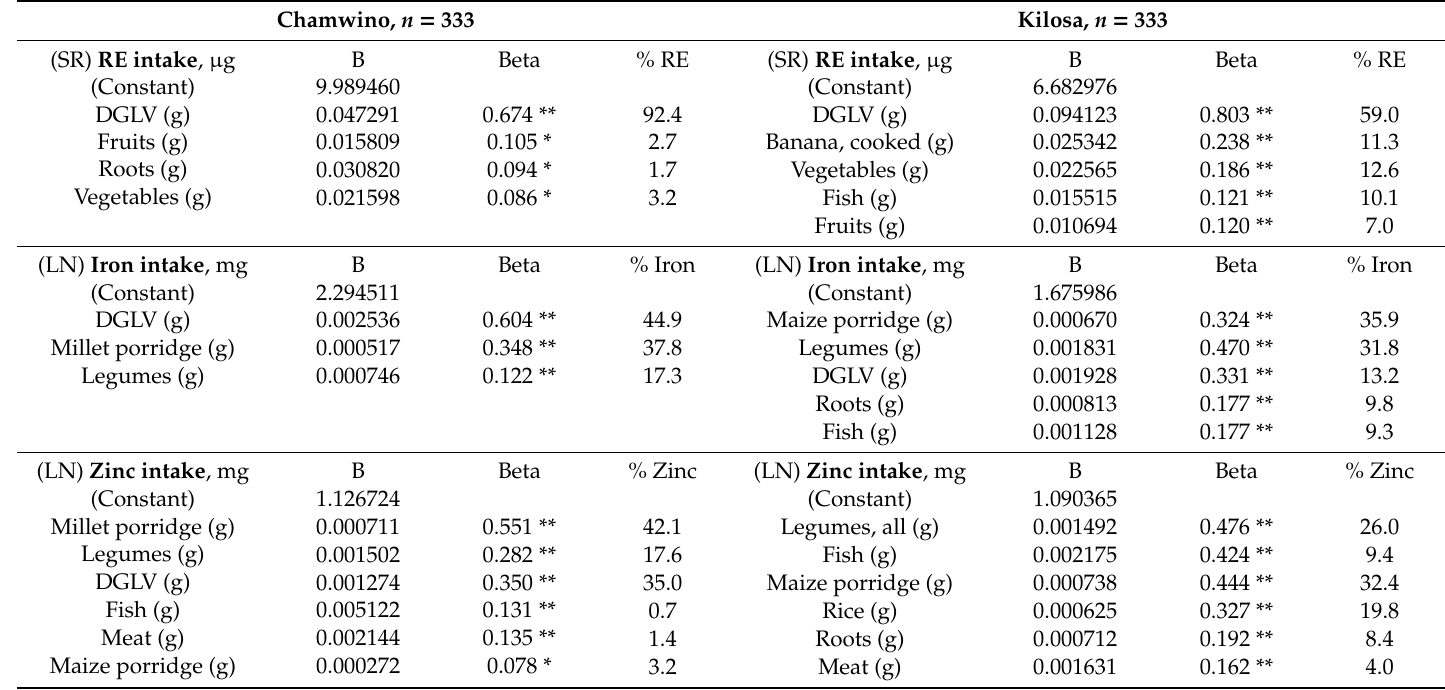
Table 5. Multiple linear regression assessing food consumption (in grams) as predictors for the calculated vitamin A (RE), iron-, and zinc intake in the